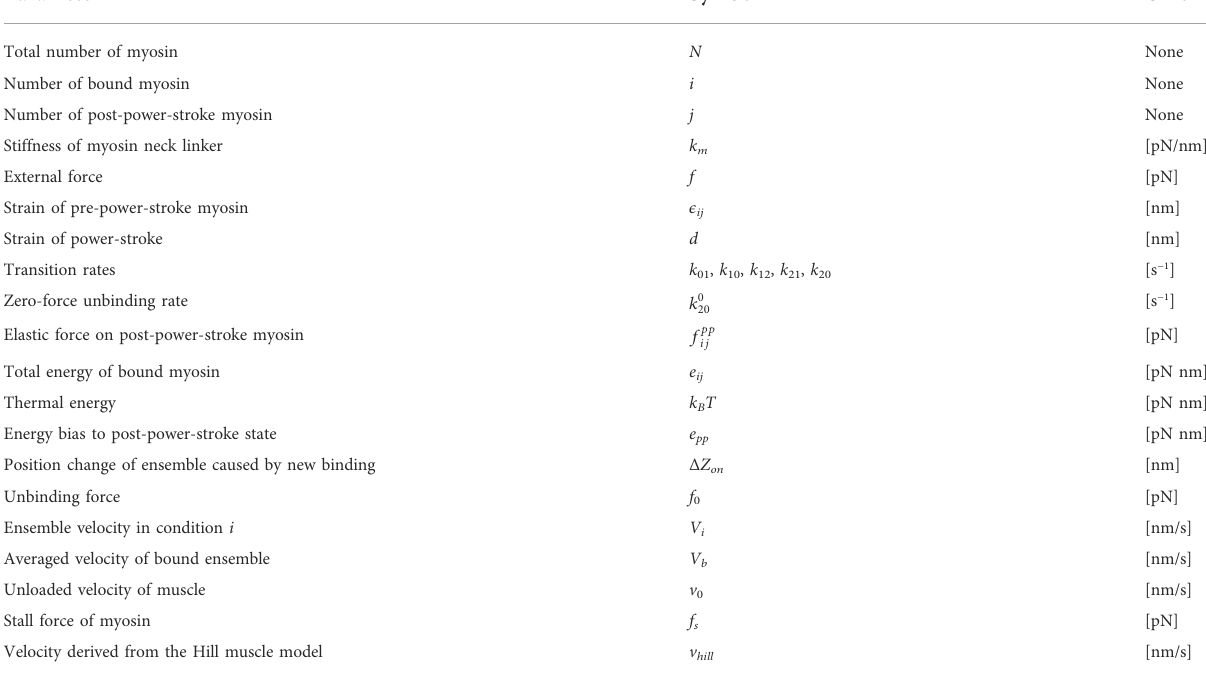
TABLE 2 Parameters in the parallel cluster